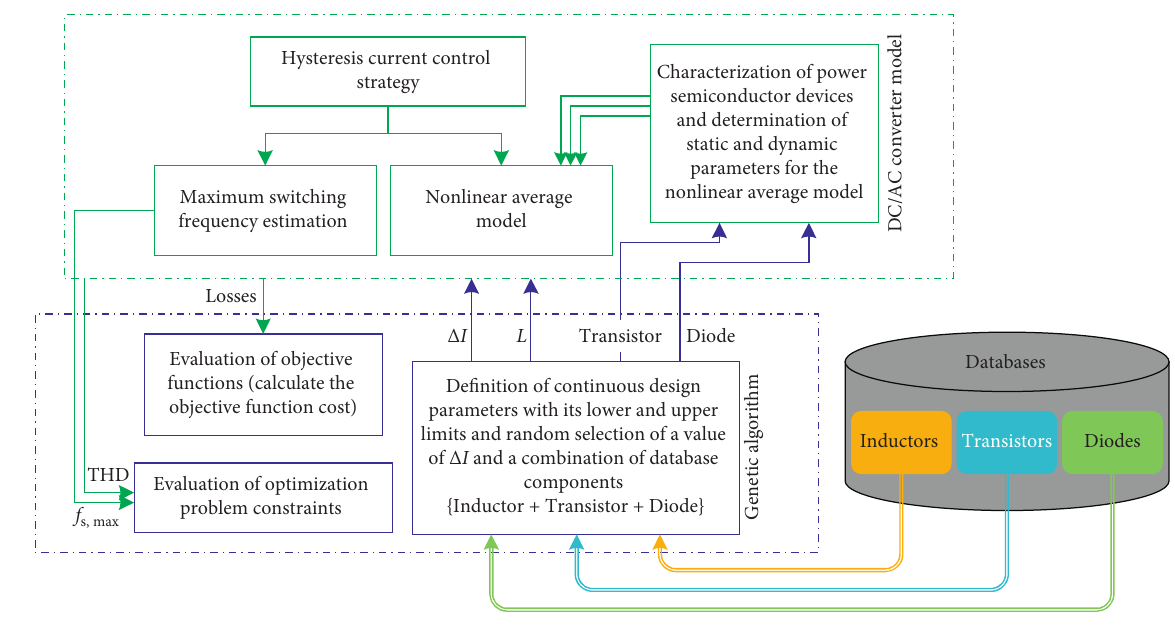
Figure 6: Optimization problem flowchart with discrete design variables. Table 1: Design